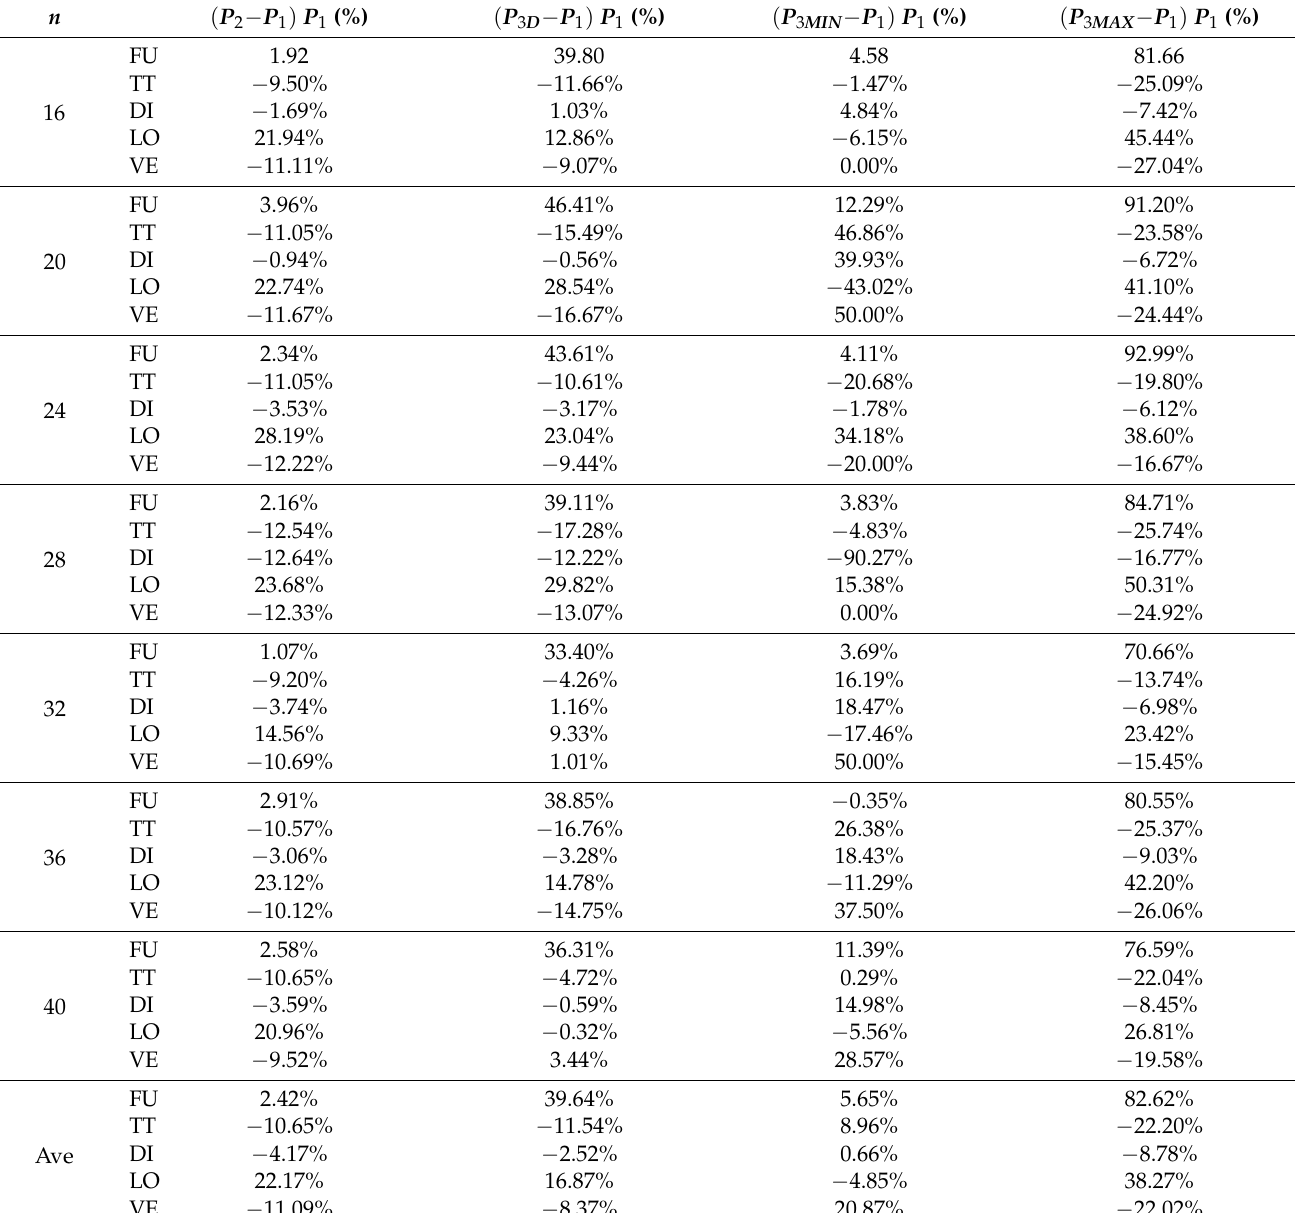
Table 3. Comparison results of P 1 , P 2 , P 3